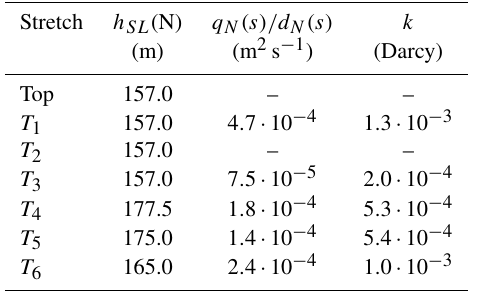
Table 4. Specific capacities and permeabilities of flow stretches for the static level determined in the case